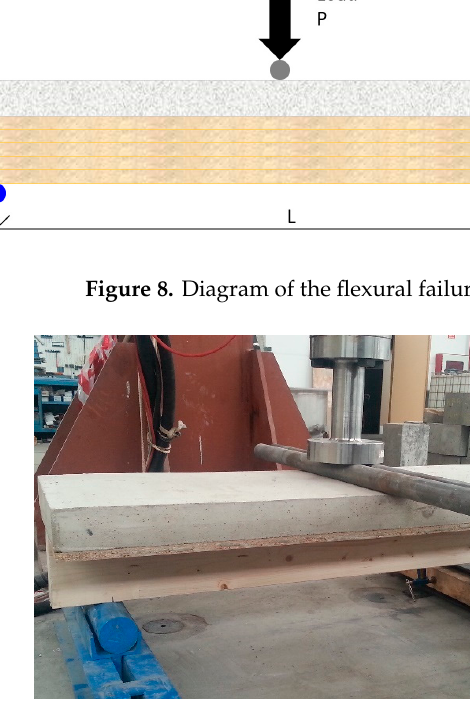
Figure 9. Flexural failure test set up.